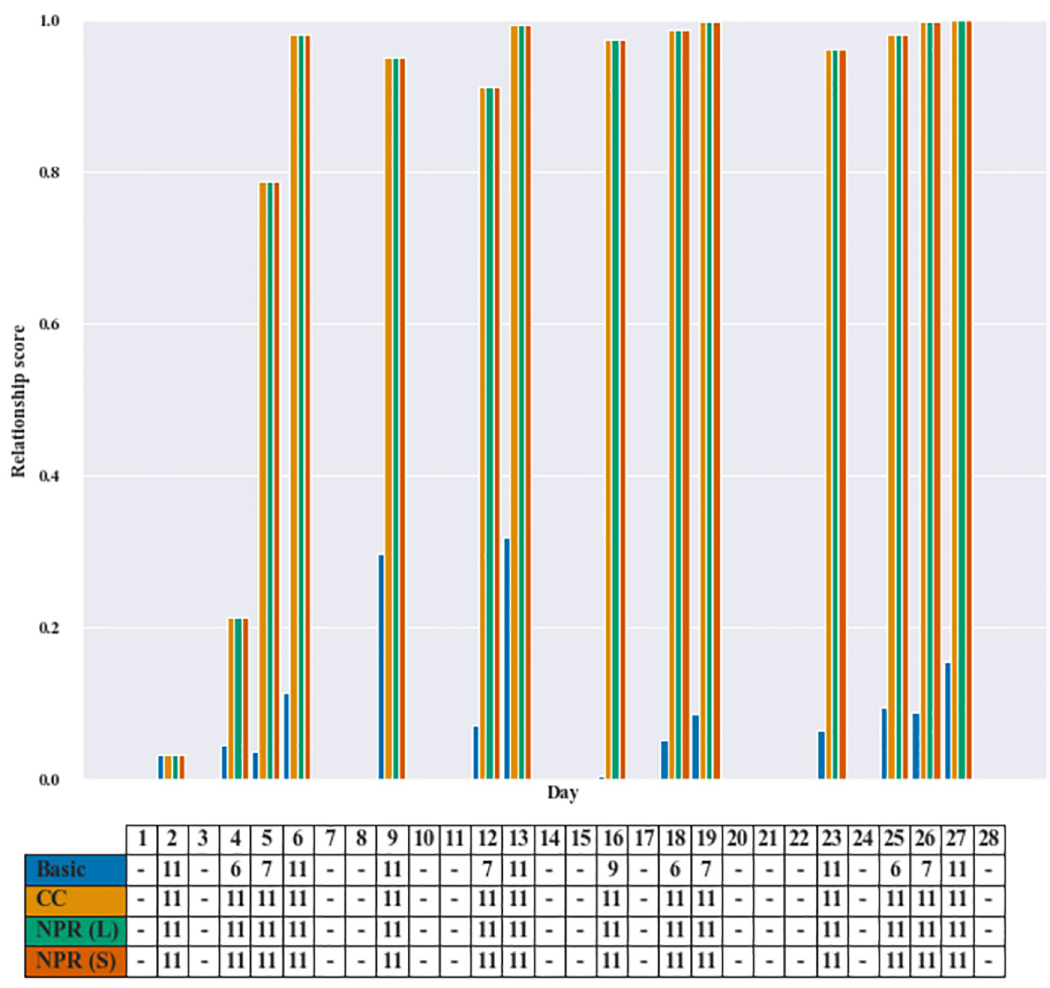
Fig 4. Instance pr18—Patient 19. The bar graph illustrates the relationship score of Patient 19 with the designated care worker ID given in the